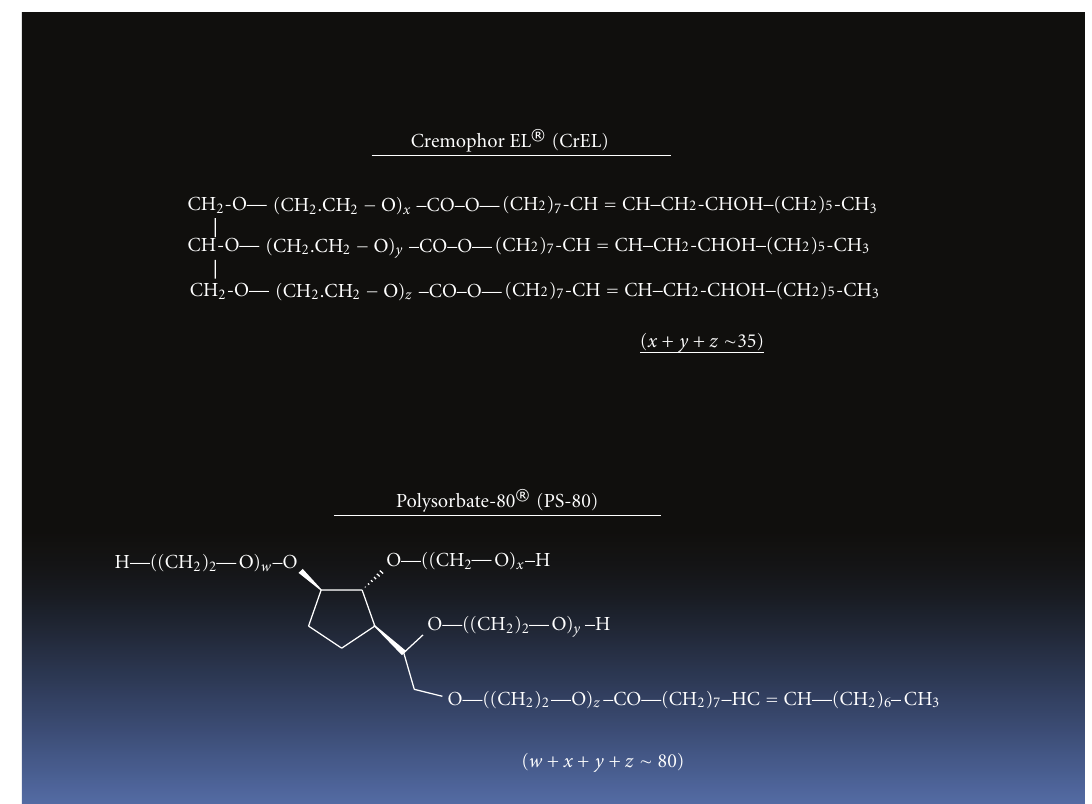
Figure 2: Chemical structures of the major components of Cremophor EL and Polysorbate-80.